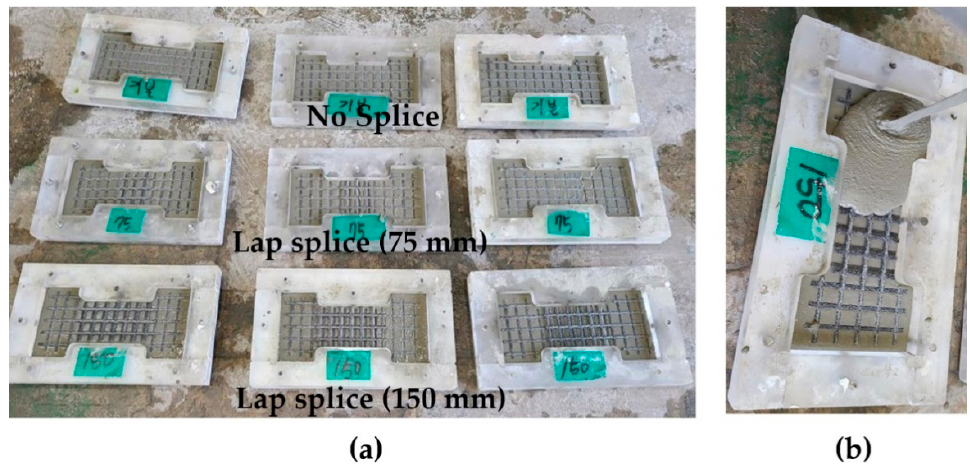
Figure 5. ( a ) Textile grid placement for TG series specimens with grout; and ( b ) grouting (TG-150).